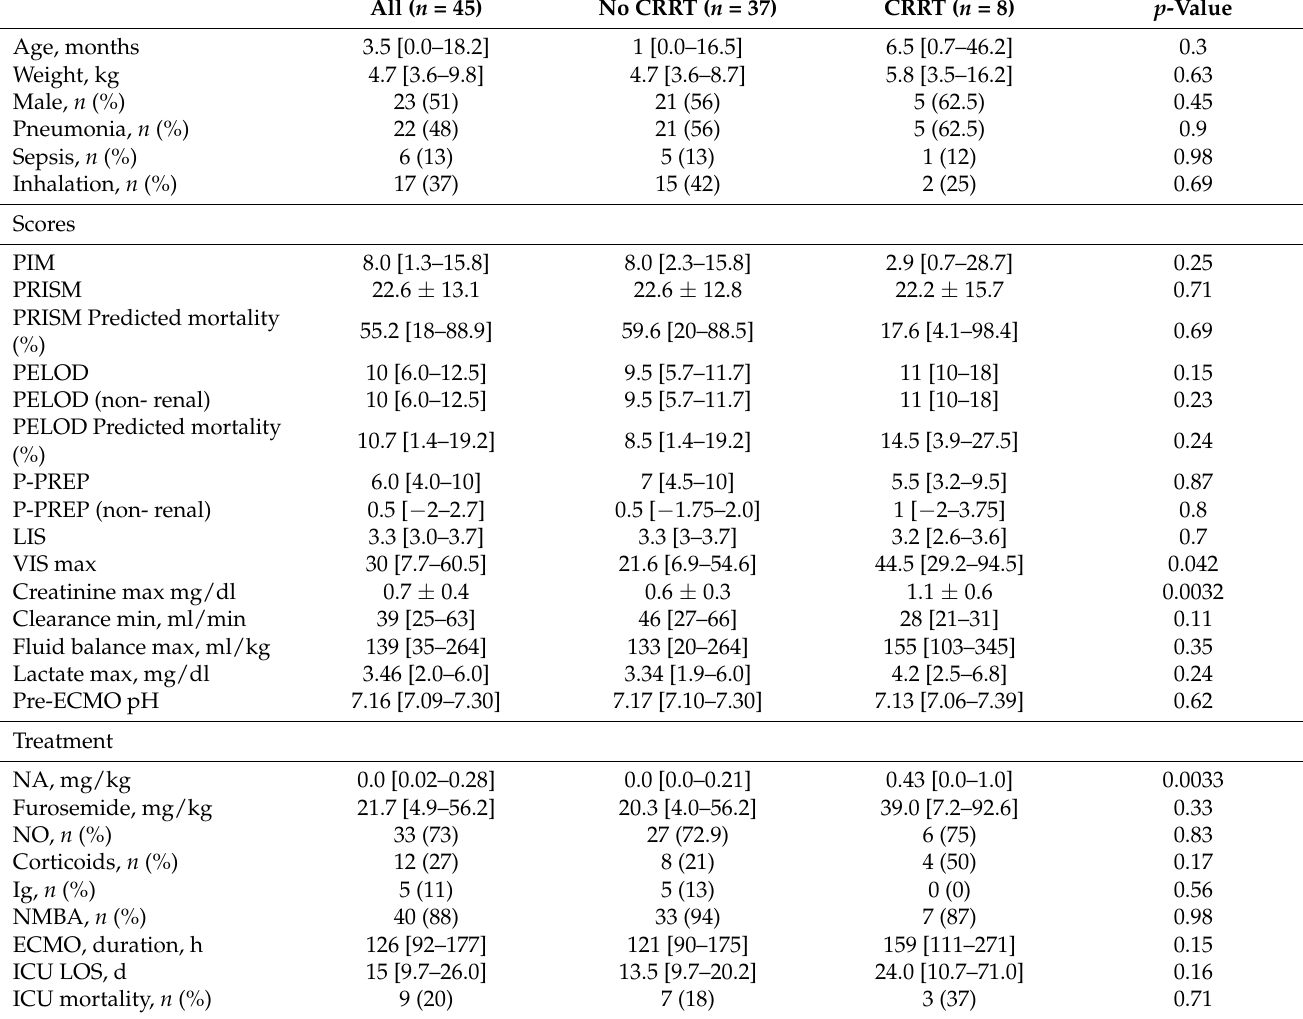
Table 1. Characteristics of the population